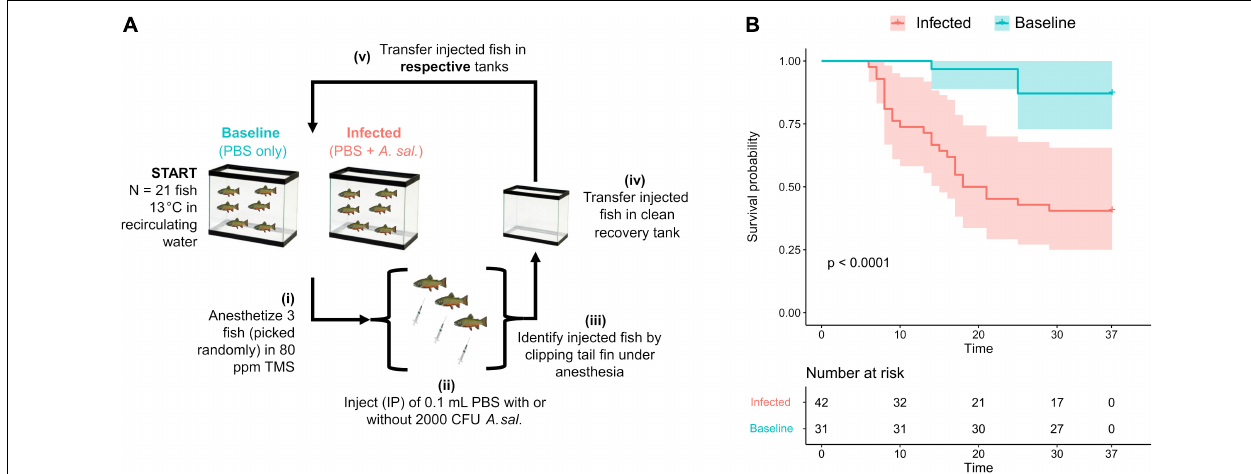
FIGURE 1 | A model system for pathogenicity studies involving A. salmonicida subsp. salmonicida . (A) Cohabitation strategy to experimentally infect brook charr with A. salmonicida subsp. salmonicida strain 890054 as the infectious agent. Even though three replicate tanks per group are required in this protocol, they were not shown here for simplicity. Infected fish and Baseline fish are kept in separate sets of three tanks to avoid cross-contamination. (B) Survival probability of brook charr infected with A. salmonicida subsp. salmonicida 890054 during a 37-day cohabitation protocol. The p -value reported in this figure is from a log-rank test of the Kaplan–Meier statistic. The colored areas represent confidence intervals (significance threshold = 0.01). Injected fish ( N = 18) were discarded from the survival analysis, hence the number of 73 individuals at risk at time T = 0. Number at risk represents the number of individuals within each group that may or may not develop furunculosis at a given